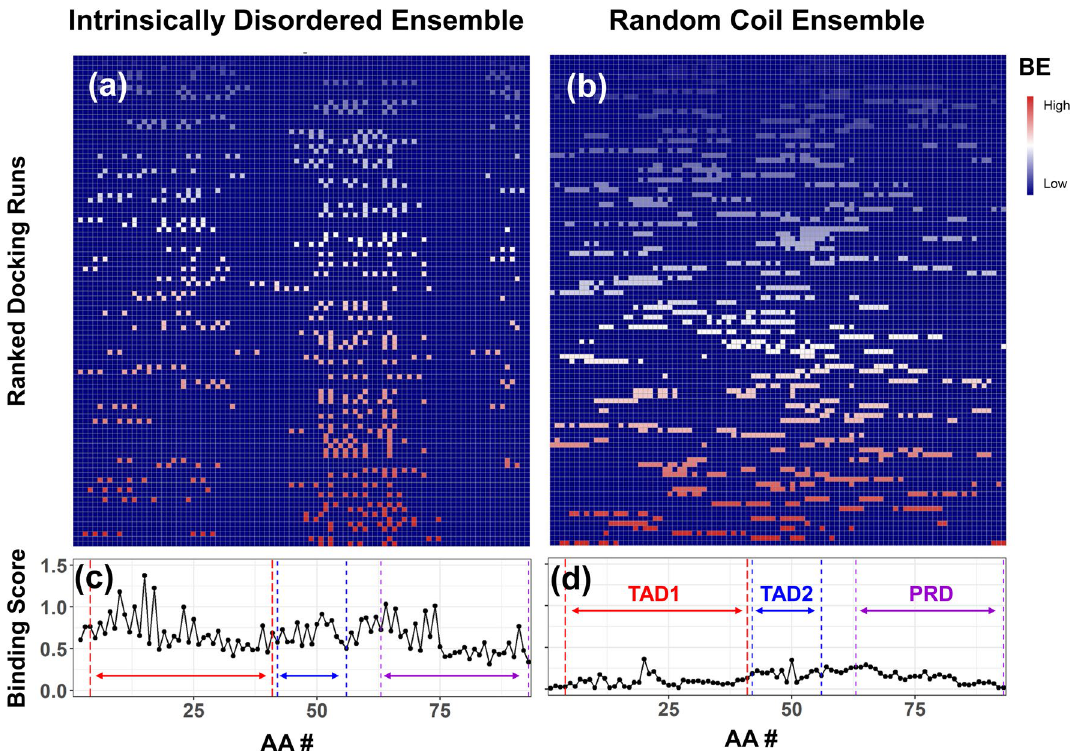
Figure 1. Docking runs and the binding score of p53-NTD interaction with EGCG. Top panels (a,b) : the intensity plot shows the binding energy (BE) from low (blue) to high (red) for each docking run (rows) for each of the amino acids that come in contact for that particular run. A representative set of top 100 binding runs is shown for ensembles with the MD generated (a) and the random coil (b) . Lower panels (c,d) : plot of the binding score (Eq. 1) plotted as a function amino acid residue position of p53-NTD. The transcriptional activation domains (TAD1 and TAD2) and the proline-rich domain (PRD) are the transcription factor activation domain 1 (TAD1, P4-D41), transcription factor activation domain 2 (TAD2, D42-E56), and the proline-rich domain (PRD, A63-L93). Within the ensemble docking runs (Fig. 1), the IDP ensemble of the p53-NTD has preferred sites in both the TAD1 and PRD domains with higher binding scores than the same regions in the random coil ensemble. The differential binding scores (DIBS) defined between IDP vs. random coil ensembles. The chemical shift perturbation data from Zhao and Blayney et al. 12 is plotted in Fig. 2a. Instead of the changes in individual chemical shifts of either 15 N or 13 C (Fig. S2), the effective chemical shift change that combines the 15 N and 13 C chemical shifts is plotted (ratio of p53-NTD EGCG = 1:4). The original chemical shift data and the prediction of the intrinsic disorder of p53-NTD are provided in the supplemental information (Figure S2a). The binding score of many of the amino acid residues match with the experimental data, and these include V10, W23, V31, L32, S37, Q38, A39 (in TAD1), residues P47, I50, E51, W53, F54, and T55 (in TAD2) and M66 and P72 (in PRD). W23 shows one of the most considerable chemical shift changes, while V10 shows the largest change in the binding score. Residues S33-L35 show chemical shift changes ( 13 CO chemical shifts, Fig. S2b) do not show notable changes visually, while residues, P27 and N30 are past the cutoff for significance (vide infra). The ensemble docking was performed on a set of conformations selected for the IDP, and random coil con- formations show a notable difference in the profiles. Are these binding events are statistically significant? To measure the differential effect, the procedure (Fig. 1) was repeated three times for each of the IDP and random coil ensembles of p53-NTD binding to EGCG. Figure 2b shows the summary of the results. The average varia- tion in the binding score as a function of the amino acid position of p53-NTD is plotted for the IDP ensembles (blue lines) and the random coil ensemble (red line) of Fig. 2b. The blue and the red ribbon represent the stand- ard deviation of the binding score over the three ensemble docking runs. The binding score plot shows several selective residues of preferential interaction between the p53-NTD with EGCG in the IDP ensemble compared to the random coil ensemble. In particular, residues in the TAD1 (V10, P13, S15, L23, and L25), few residues in the smaller TAD2 (D49, and E51), and several residues in the PRD (G59, P64, M66, A70, P72, and A74) have preferential interactions with EGCG. In contrast, such interactions with the random coil ensembles are absent. The amino acid residues that tend to interact with EGCG also happen to be clustered at the N-terminal part of the TAD1, interface between the TAD2 and PRD, and the N-terminal domain of PRD. Considering that p53-NTD is an IDP (Fig. S2a), even at a spectrometer frequency of 800 MHz, it is impos- sible to identify all the NMR chemical shifts assignments due to an overlap of resonances or line broadening